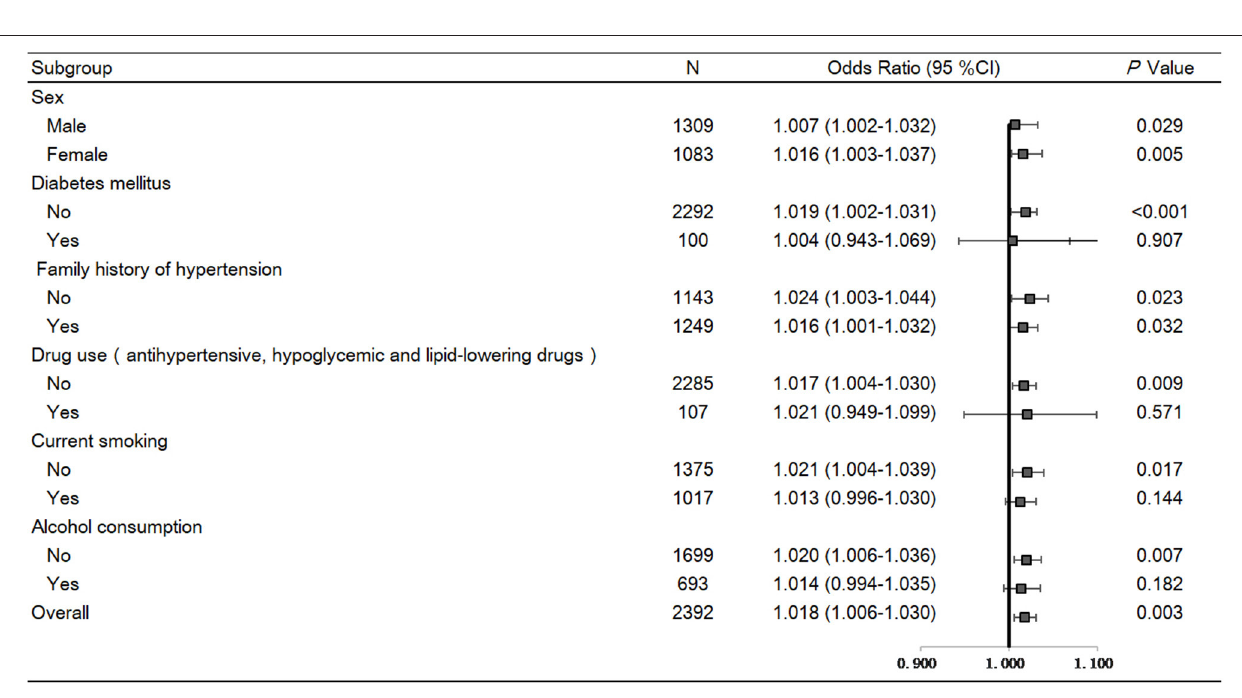
FIGURE 2 | Forest plots of odds ratios (ORs) for serum renalase and risk of hypertension in a total of 2,392 subjects stratified by sex, BMI, diabetes, family history of hypertension, and drug use. Logistic regression analyses to test associations of serum renalase with hypertension risk after adjustment for age, smoke, BMI, eGFR, total cholesterol, triglycerides, fasting glucose. Values are the OR (95% confidence interval [95% CI]). and focused on human samples rather than animal